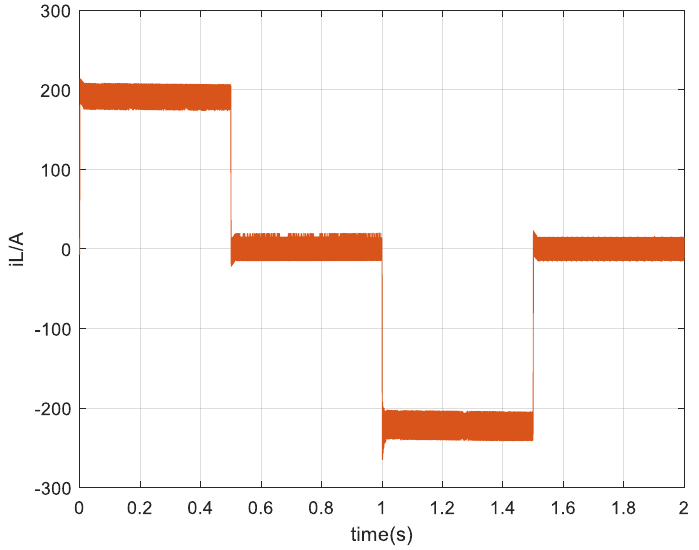
Figure 10. Simulation result of inductor current under proposed control method.